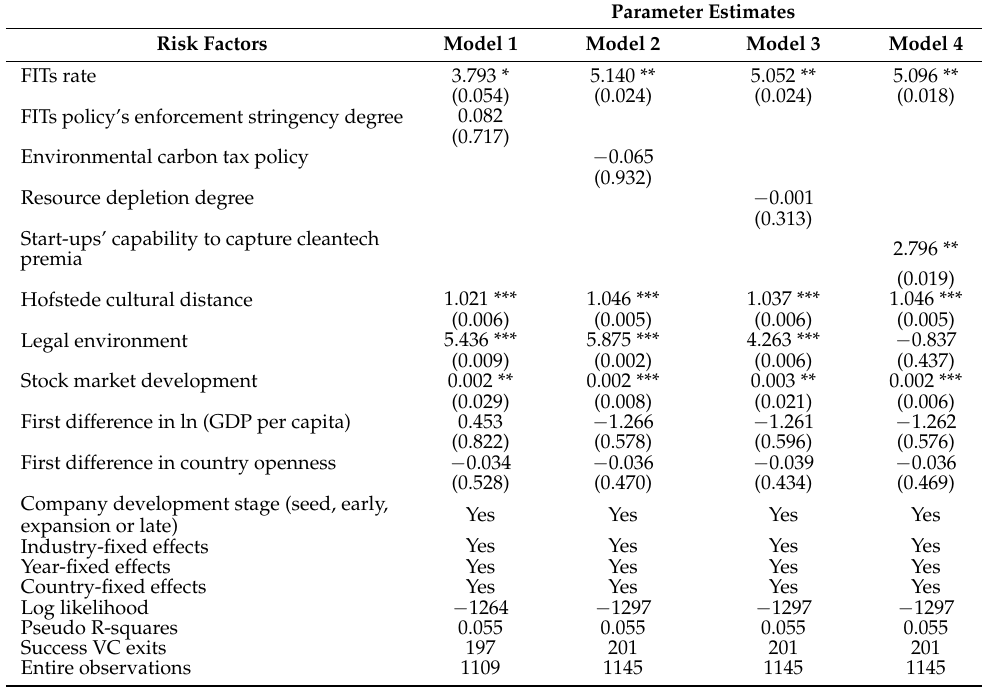
Table 8. Robustness check on 1159 VC-backed cleantech